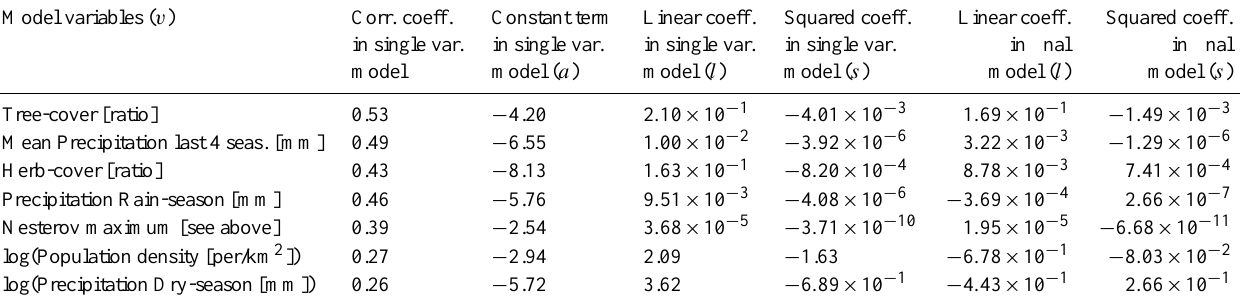
Table 1. Parameterisation of model VC. Correlation coefficient (R-value) of all models with variables used as single predictors; constant linear and squared coefficients of the single variable models and of model VC. The constant term for the final model is − 10.06. The abbreviations v , l and s are used in Eq. (5).